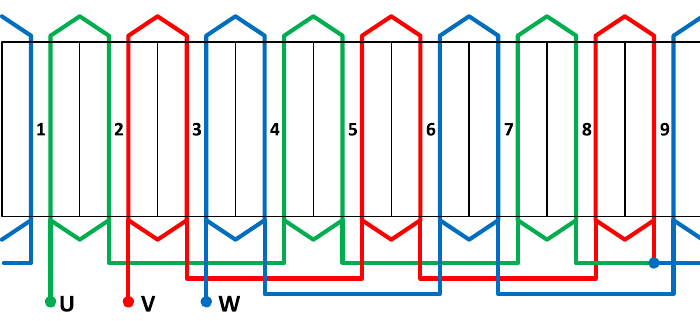
Figure 5. Machine dimensions calculated during the design process.